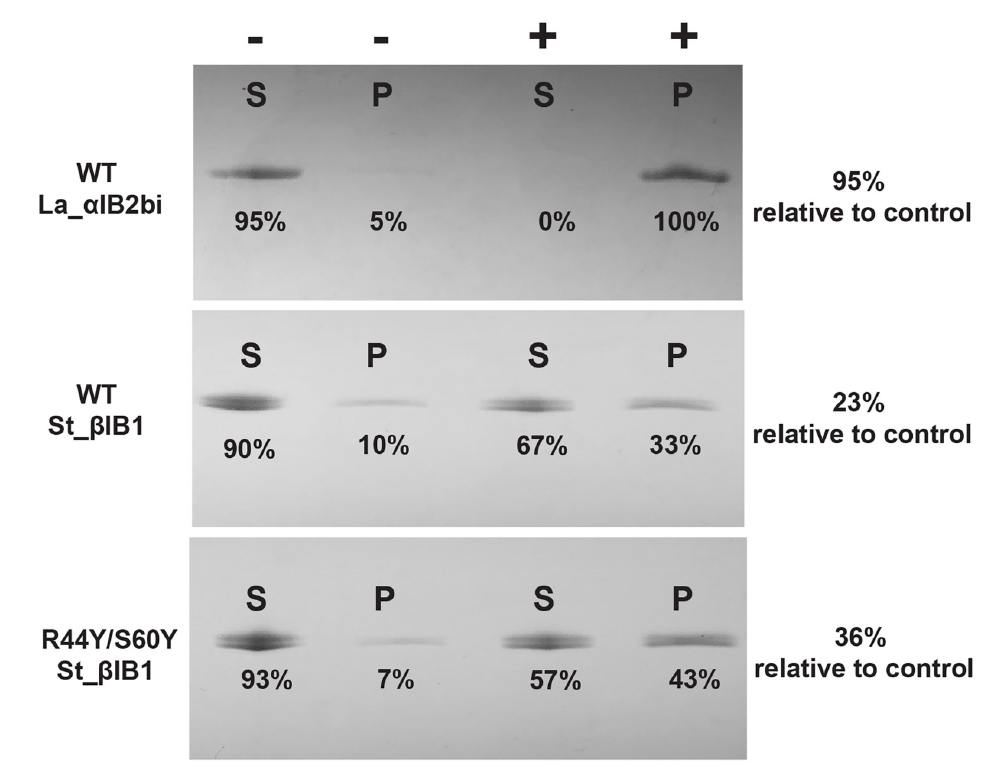
Fig 9. Liposome binding assay for WT La_ α IB2bi, WT St_ β IB1 and R44Y/S60Y St_ β IB1 on SM:CHOL (1:1) liposomes. P and S refer to pellet and supernatant, respectively. The “-” symbol indicates the control lanes (without liposomes) and the “+” symbol the lanes with the protein and the liposomes. The St- β IB1 and mutant data shown here represent the single run closest to the mean increase. Data for the three individual runs are found in Table A in S3 Text. Across three experiments the mutant R44Y/S60Y St_ β IB1 showed 10–17% higher levels of pulldown than the WT, giving a mean increase of 13 ± 2%.